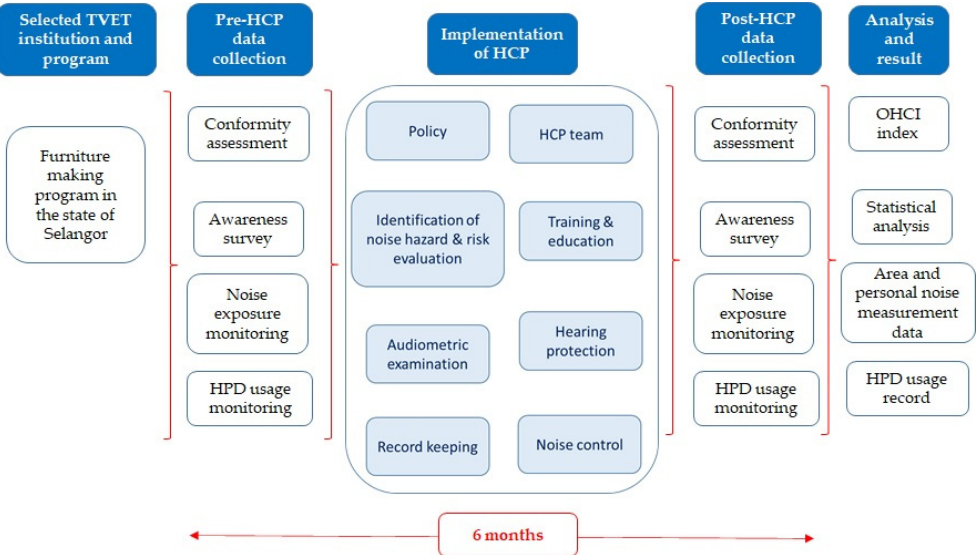
Figure 2. Study framework.